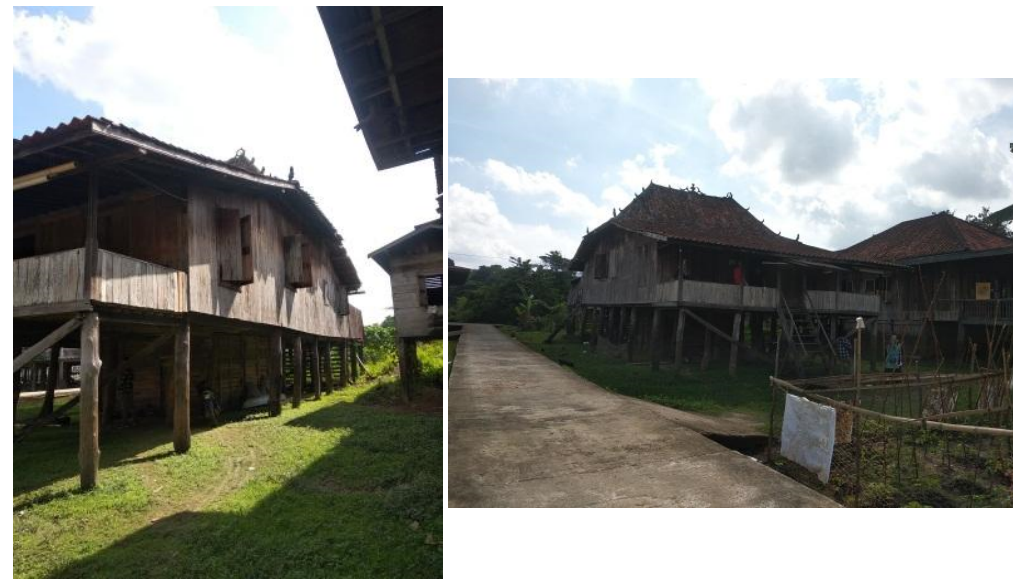
Fig. 3. Seberang Kota Jambi Stilt House.